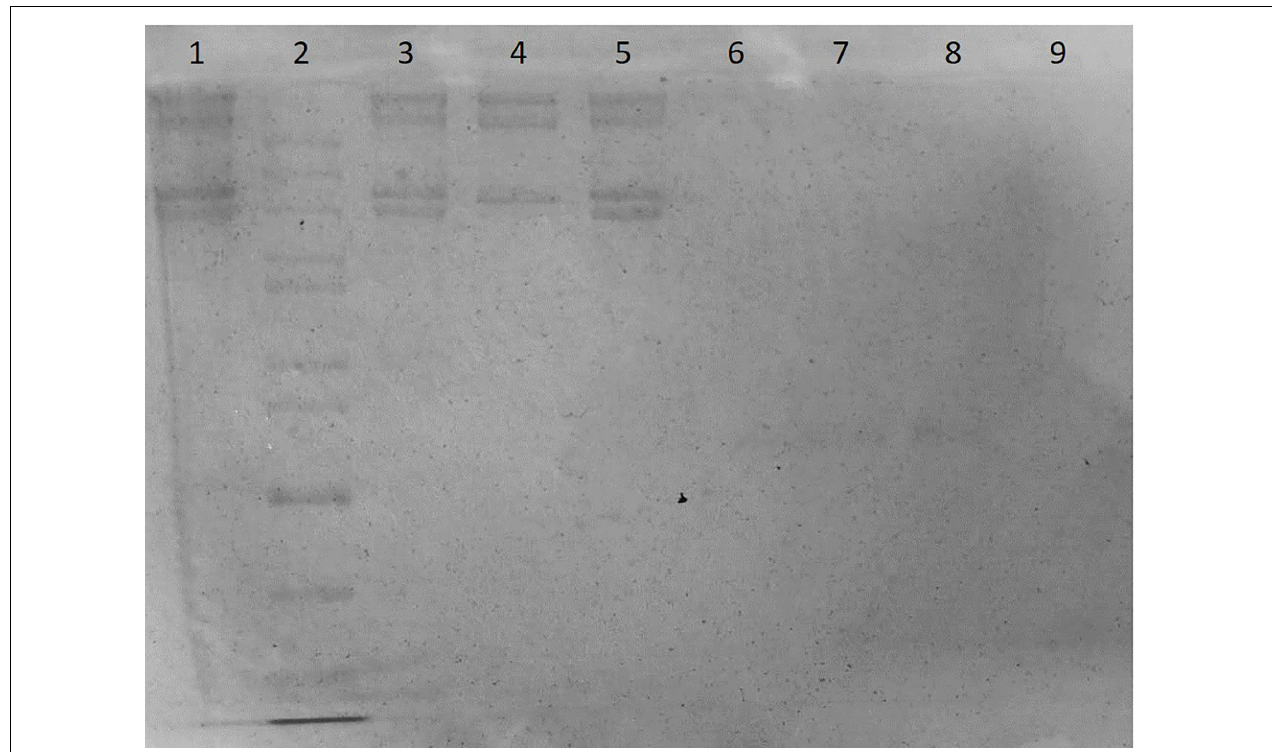
FIGURE 2 | The SDS-PAGE of dura substitute (Lane 1, 3, 5: sample A, collagen solution; Lane 2: sample E, molecular weight ladder; Lane 4: sample F, control type I collagen; Lane 6: sample B, digested collagen solution; Lanes 7, 8: sample D, BSA; Lane 9: sample C, collagenase solution).